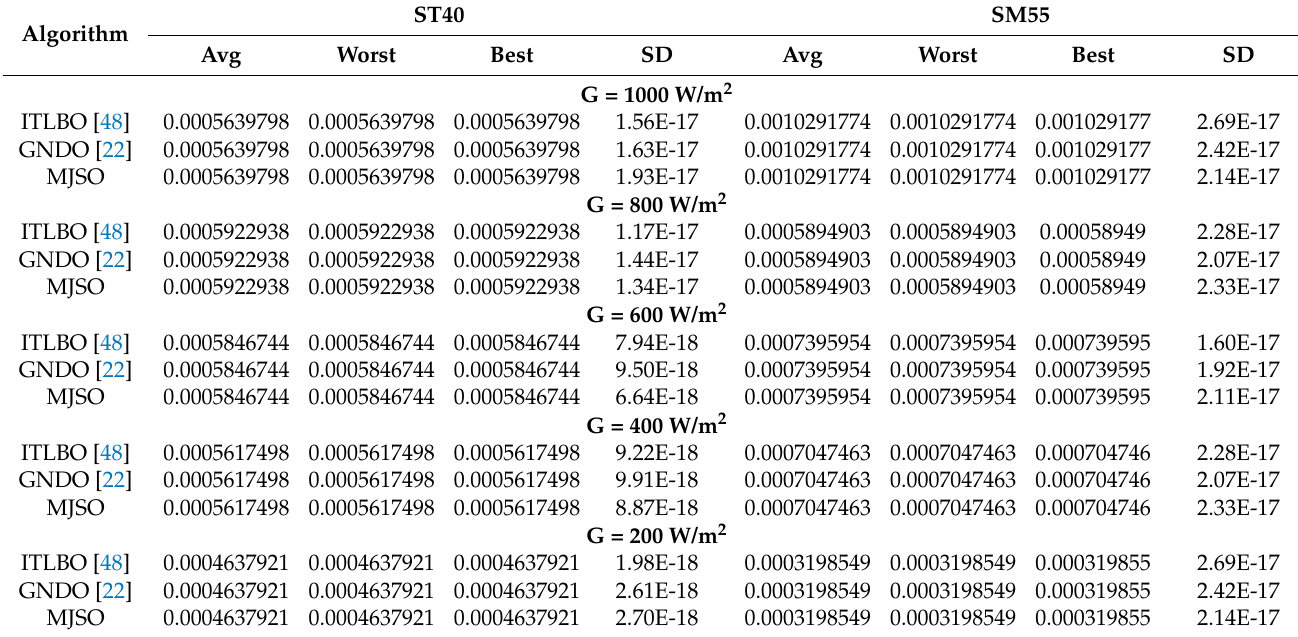
Table 14. Comparison at T = 25 ◦ C and various G.